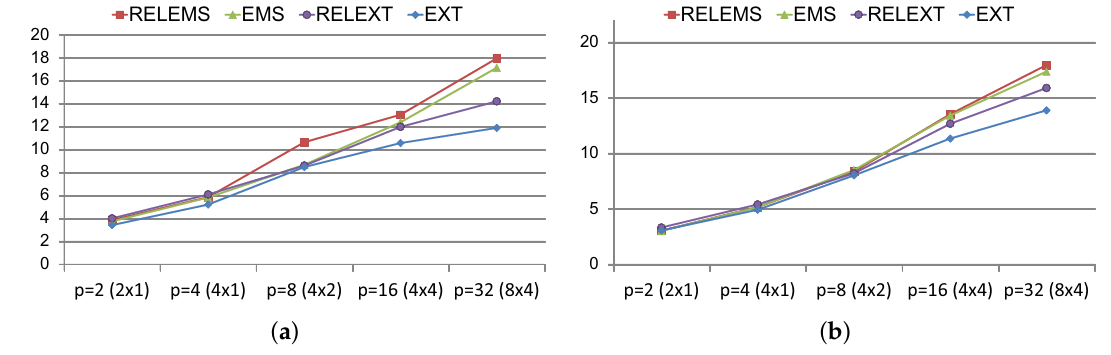
Figure 7. Non-stationary versus extrapolated Power algorithms, (cid:101) = 10 − 6 , α = 0.99. ( a ) webbase-2001 (Speedup). ( b ) it-2004